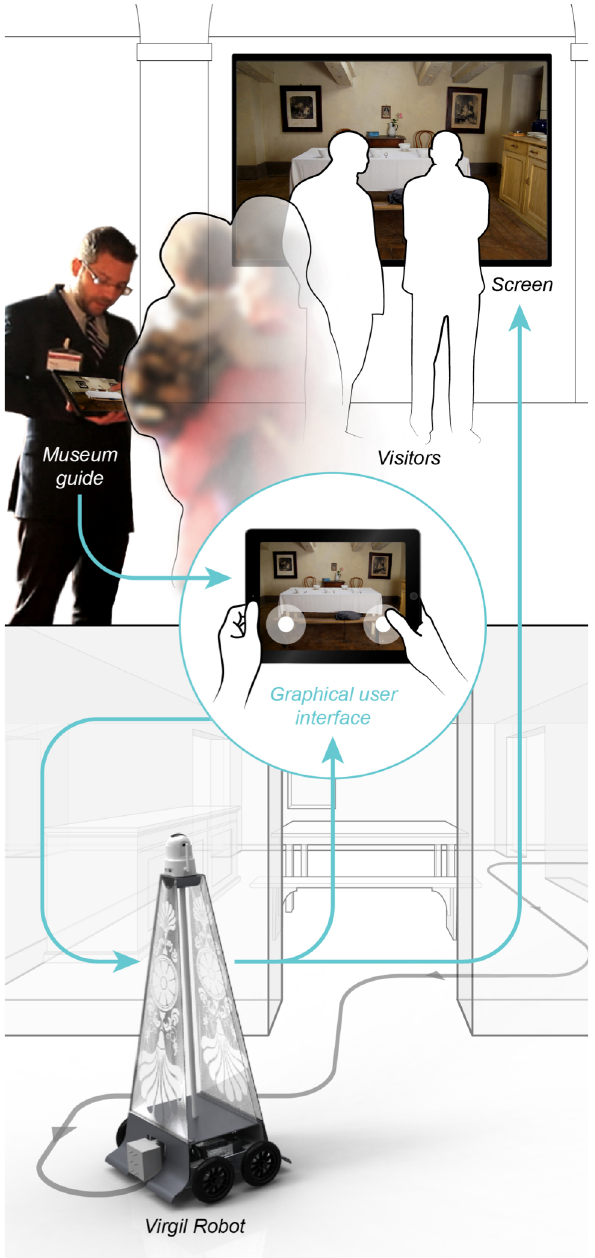
Figure 3 | The new robotic museum experience: general schema of the